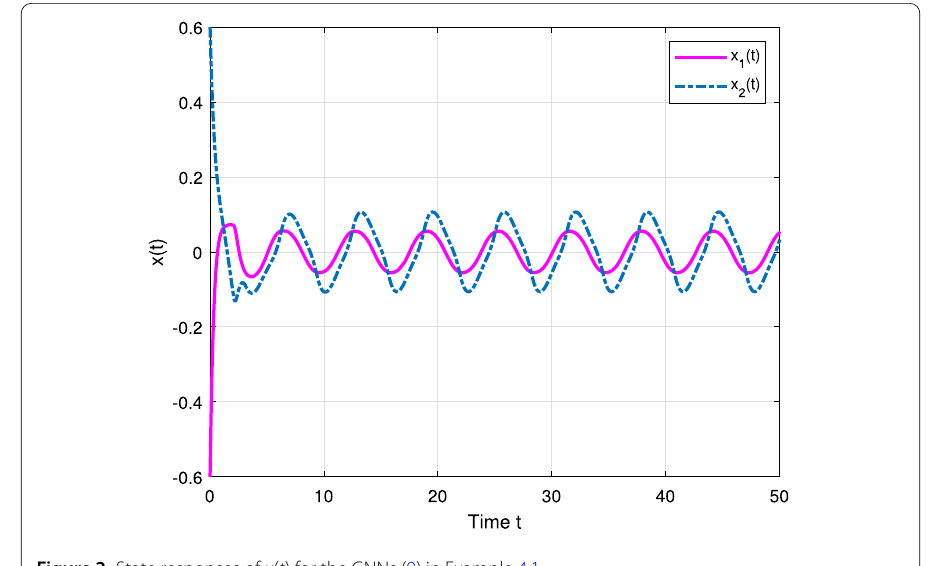
Figure 2 State responses of x ( t ) for the GNNs (9) in Example 4.1